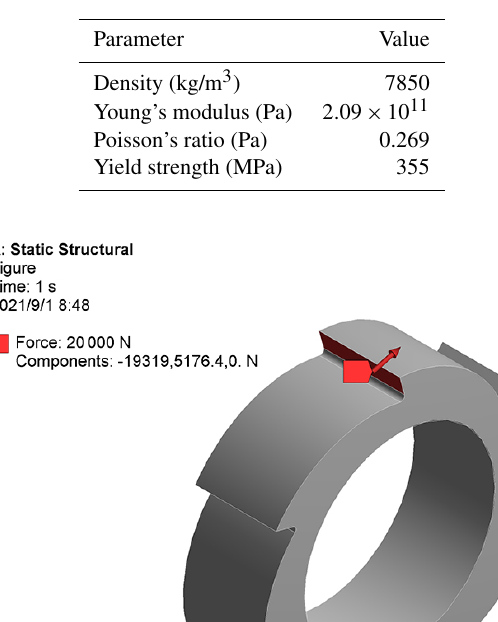
Table 3. Experiment apparatus and